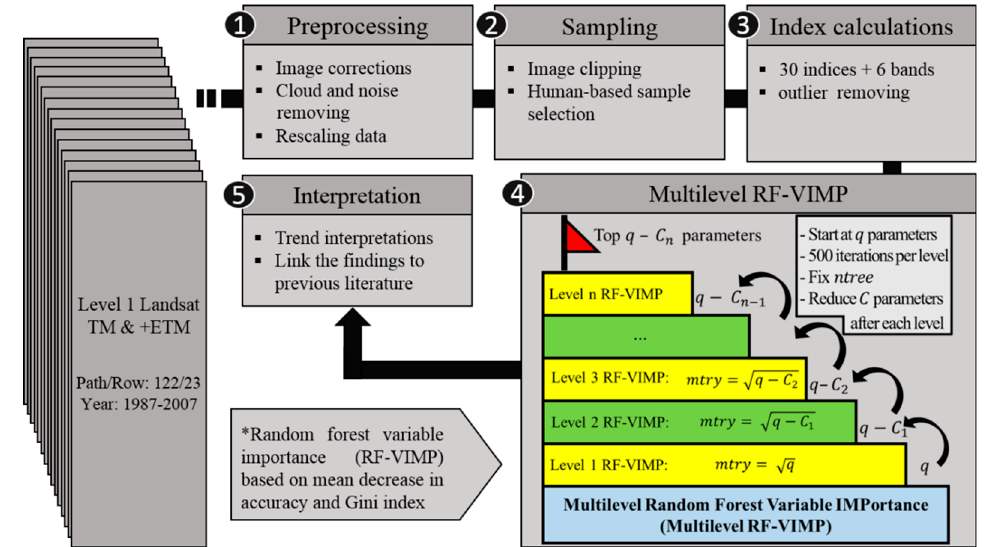
Figure 5. The multilevel random forest variable importance (RF-VIMP) system for burnt forest recovery monitoring.